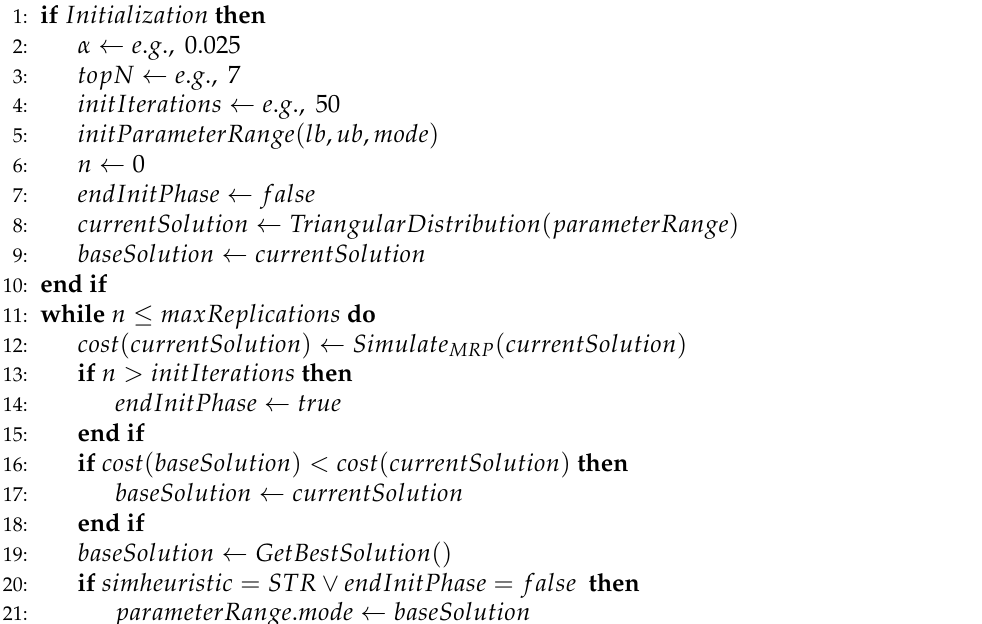
Algorithm 1 Base Simheuristic